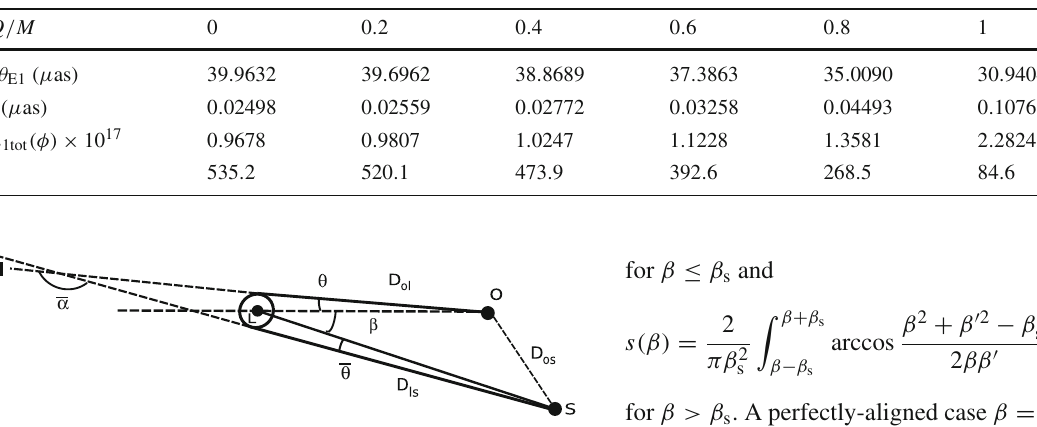
Table 2 Gravitational lensing in the usual lens configuration with deflection angle (1.1): We set M , D os , D ol , D ls , φ , and a to be the same values as the ones in Table 1. We do not show ¯ a , ¯ b , and 2 θ ∞ because they give the same values as the ones in Table 1